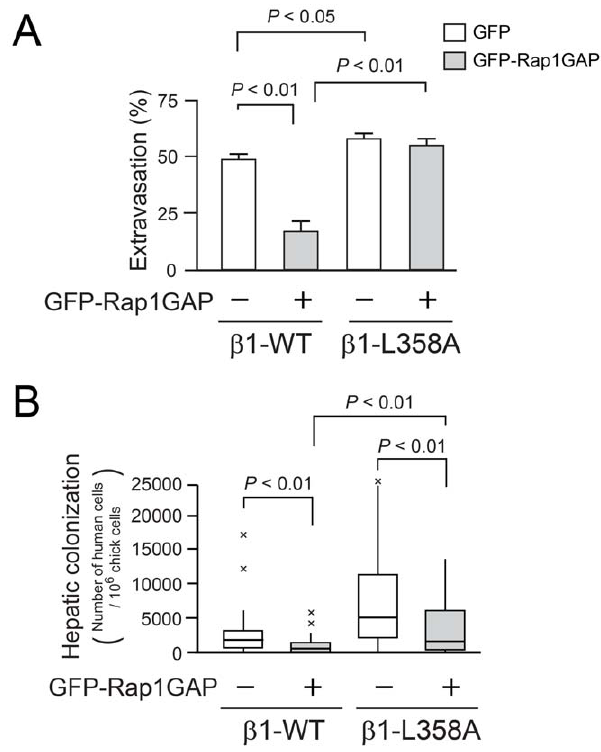
Figure 5. Rap1GAP suppresses hepatic colonization of tumor cells. (A) Tumor cell extravasation from liver sinusoids. Tumor cell extravasation was determined as in Figure 3 ( b 1-WT + GFP: 168 cells, b 1- WT + GFP-Rap1GAP: 101 cells, b 1-L358A + GFP: 84 cells, b 1-L358A + GFP-Rap1GAP: 144 cells; five independent experiments). (B) Box plot showing the effect of Rap1GAP overexpression on hepatic colonization by MDA-MB435 b 1-WT or b 1-L358A cells ( b 1-WT + GFP: n=28, b 1-WT + GFP-Rap1GAP: n=31, b 1-L358A + GFP: n=30, b 1-L358A + GFP- Rap1GAP: n=29).